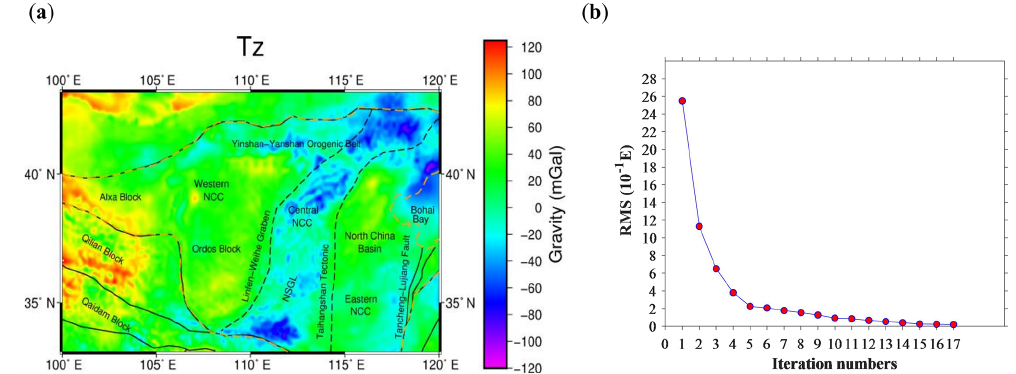
Figure 5. (a) The corrected gravity anomalies after several corrections. (b) With the iterative calculation, residual mean square between the forward-calculated theoretical gravity and the gravity measurements versus the iteration number in the PCG inversion